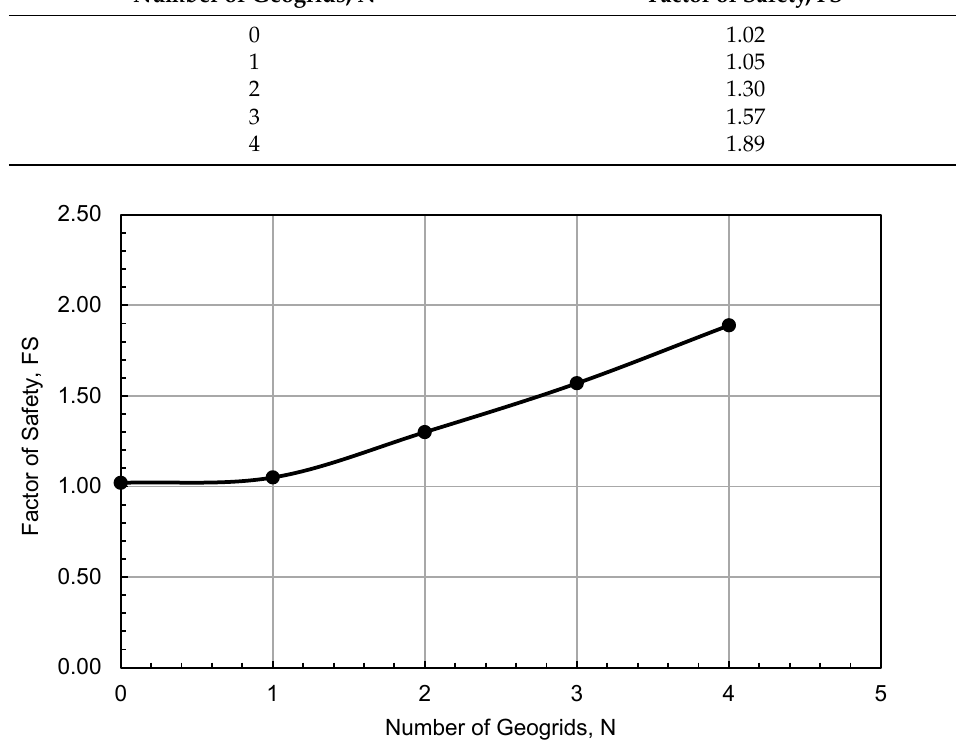
Table 9. LEM analysis results for the reinforced slope (1V/2H slope, N = 4). Number of Geogrids, N Factor of Safety, FS 0